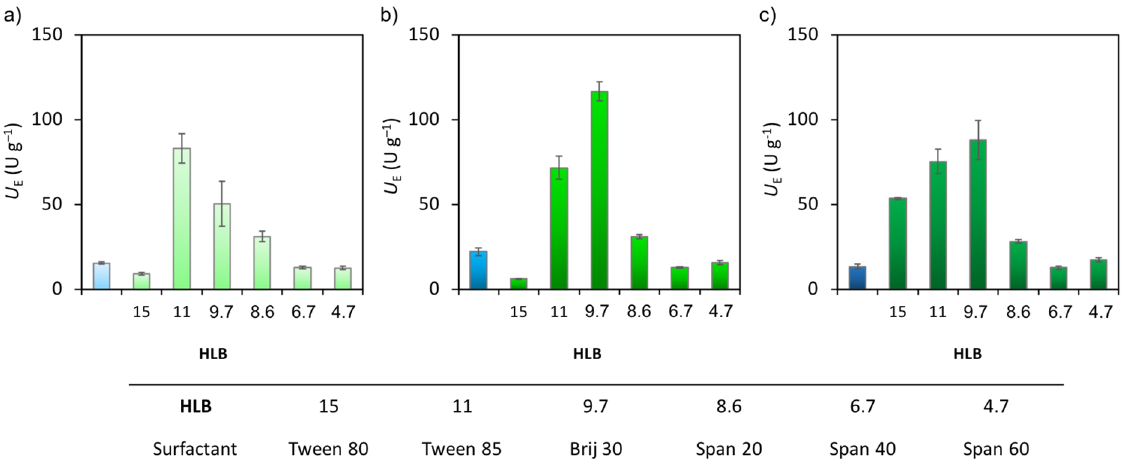
Figure 9. The effect of the surfactants (Tween 80, Tween 85, Brij 30, Span 20, Span 40, and Span 60) with different HLB values on the specific enzyme activity ( U E ) of Pc PAL entrapped in PLA nanofibers (colored with green bars), and Pc PAL entrapped in surfactant-free PLA nanofibers (colored with blue bars) at ( a ) 0.1 w/w%, ( b ) 0.15 w/w%, and ( c ) 0.2 w/w% Pc PAL contents in ammonia elimination from L -phenylalanine. Every measurement was made in triplicate, the difference between PcPAL entrapped in PLA nanofibers at different enzyme loading without emulsifiers (colored with blue bar) and samples with emulsifier is significant ( p < 0.005) in all cases, except samples Span 60 at 0.1 and 0.15 w/w% enzyme loading and Span 40 and Span 60 at 0.2 w/w% enzyme